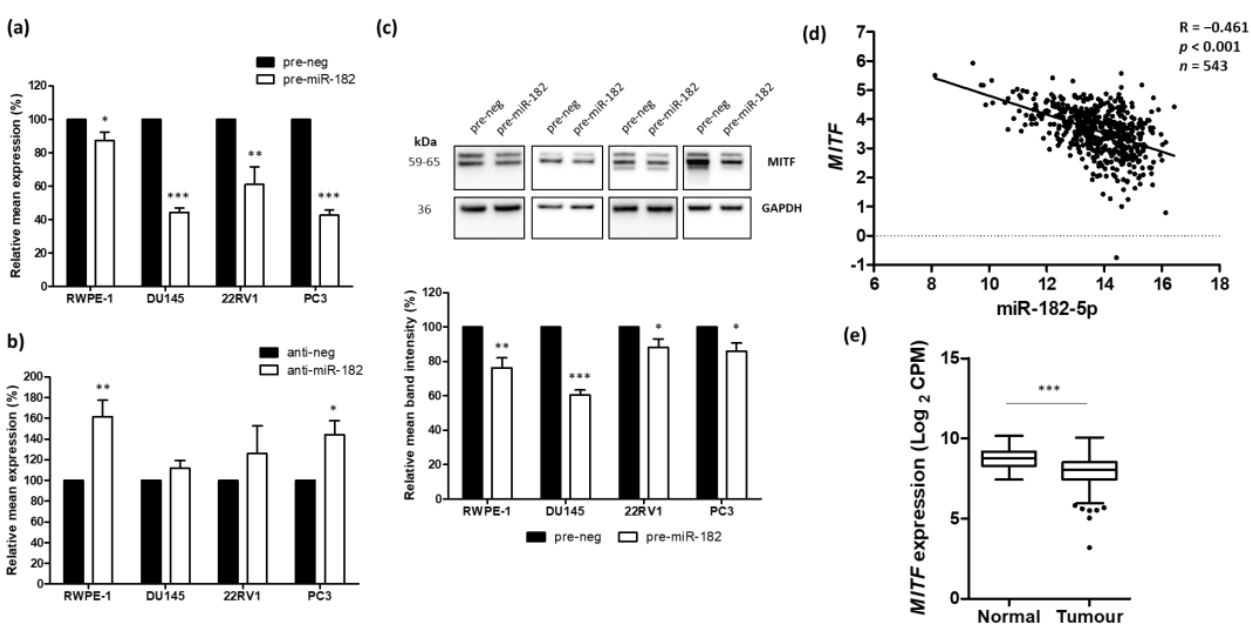
Figure 5. Validation of MITF as a novel target of miR-182 in prostate cancer cells. ( a ) RT-qPCR (n = 4) shows over-expression of miR-182 causes significant down-regulation of MITF in normal and cancerous prostate cell lines (paired t -test, * p < 0.05, ** p < 0.01, *** p < 0.001). ( b ) RT-qPCR (n ≥ 3) shows inhibition of miR-182 causes significant up-regulation of MITF in RWPE-1 and PC3 cells (paired t -test, * p < 0.05, ** p < 0.01). ( c ) Representative and quantified Western blotting (n ≥ 4) shows over-expression of miR-182 causes significant down-regulation of MITF in normal and cancerous prostate cell lines (paired t -test, * p < 0.05, ** p < 0.01, *** p < 0.001). ( d ) CancerMIRNome analysis of TCGA prostate specimens, including normal (n = 52) and tumor (n = 491) tissue samples, shows the expression of miR-182 and MITF are significantly negatively correlated (Pearson correlation, p < 0.001). ( e ) UCSC Xena analysis of TCGA-PRAD samples shows MITF expression is the inverse of miR-182, being significantly reduced in tumor (n = 497) tissues relative to normal (n = 52) tissue (Welch’s t -test, *** p < 0.001).